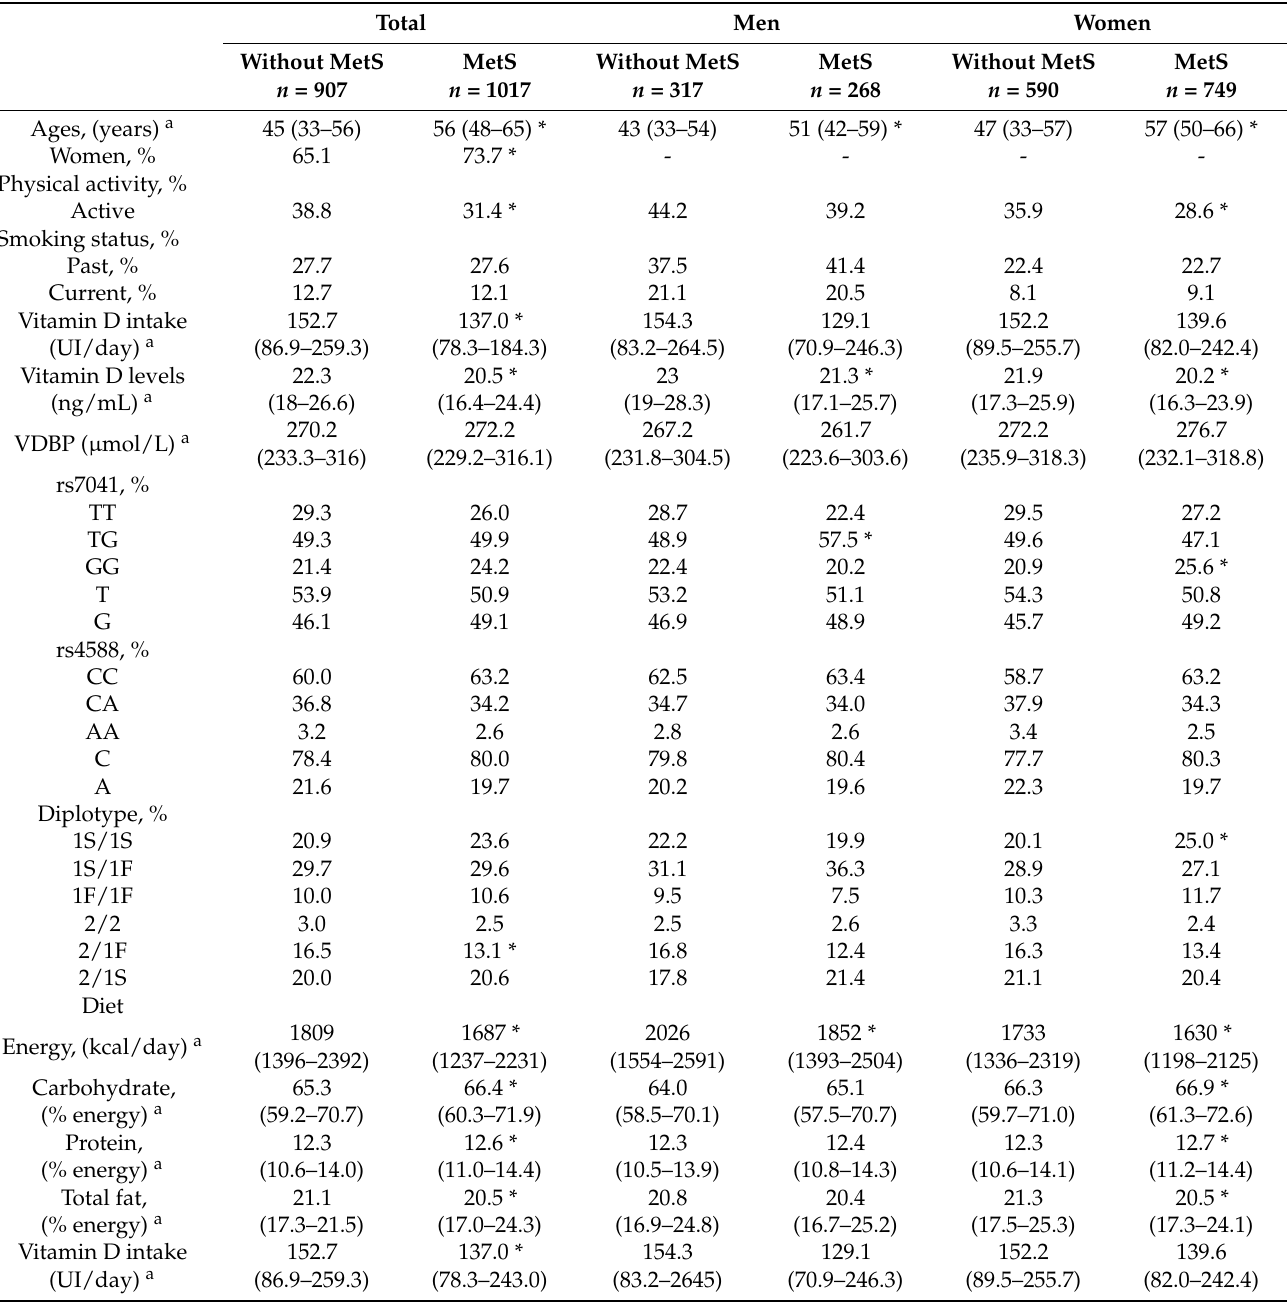
Table 1. Distribution of sociodemographic characteristics and lifestyle factors according to metabolic syndrome status and